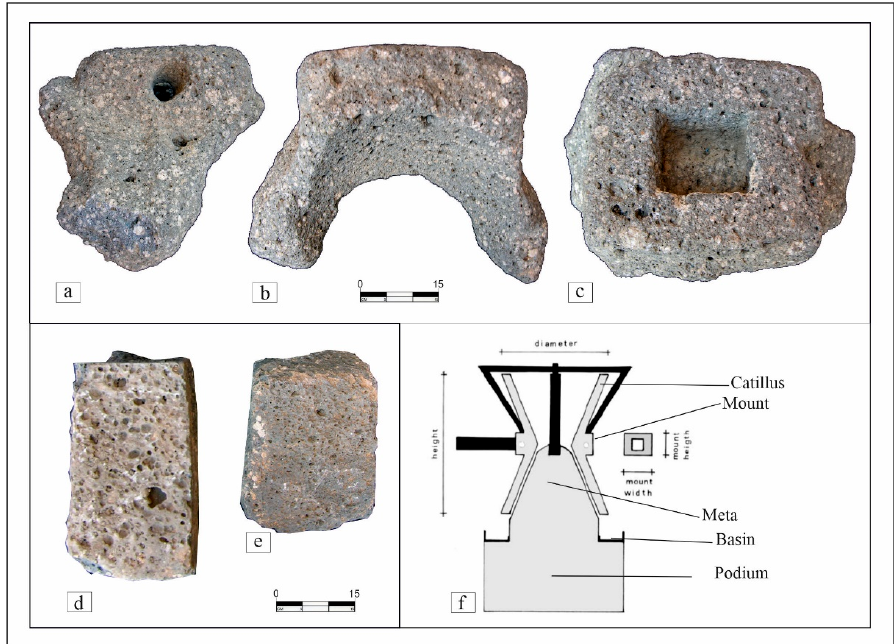
Figure 1 . ( a ) L15 Manoppello millstone, lateral catillus; ( b ) L15, frontal catillus; ( c ) L15 lateral mount; ( d ) L14A podium; ( e ) L14B meta; ( f ) hourglass millstone structure.